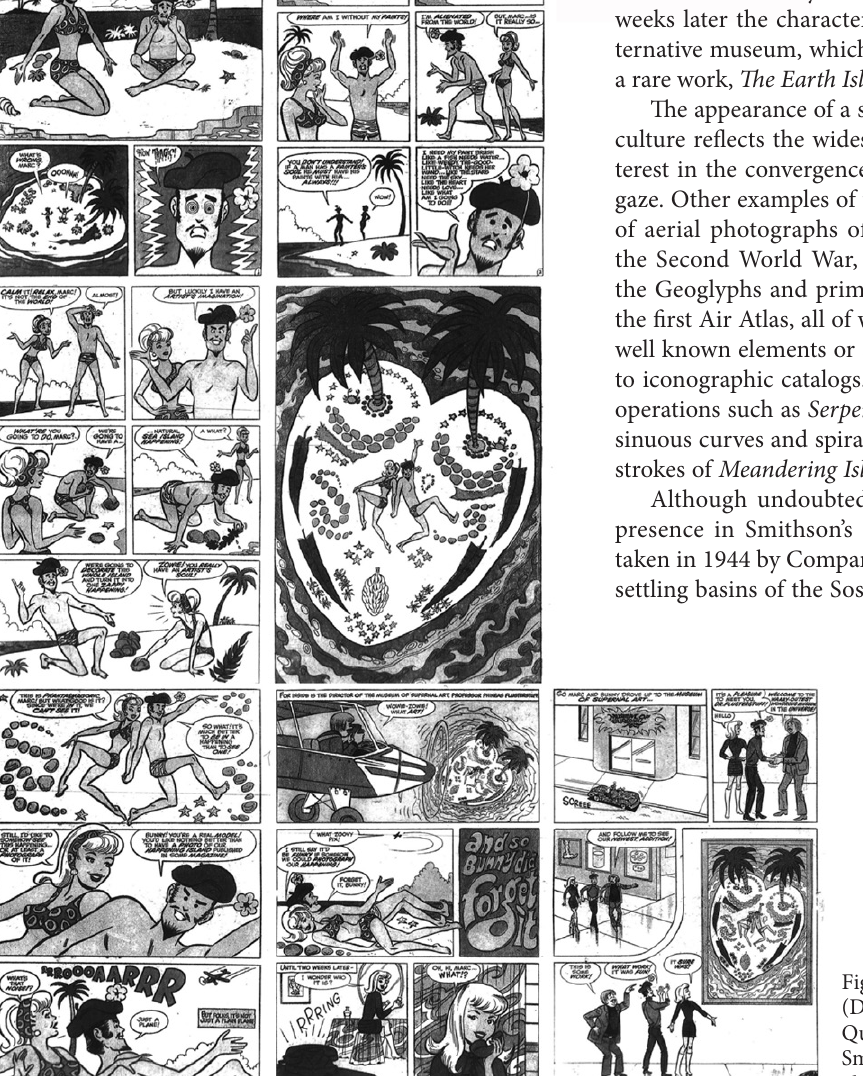
Figure 15. “The Heart Island